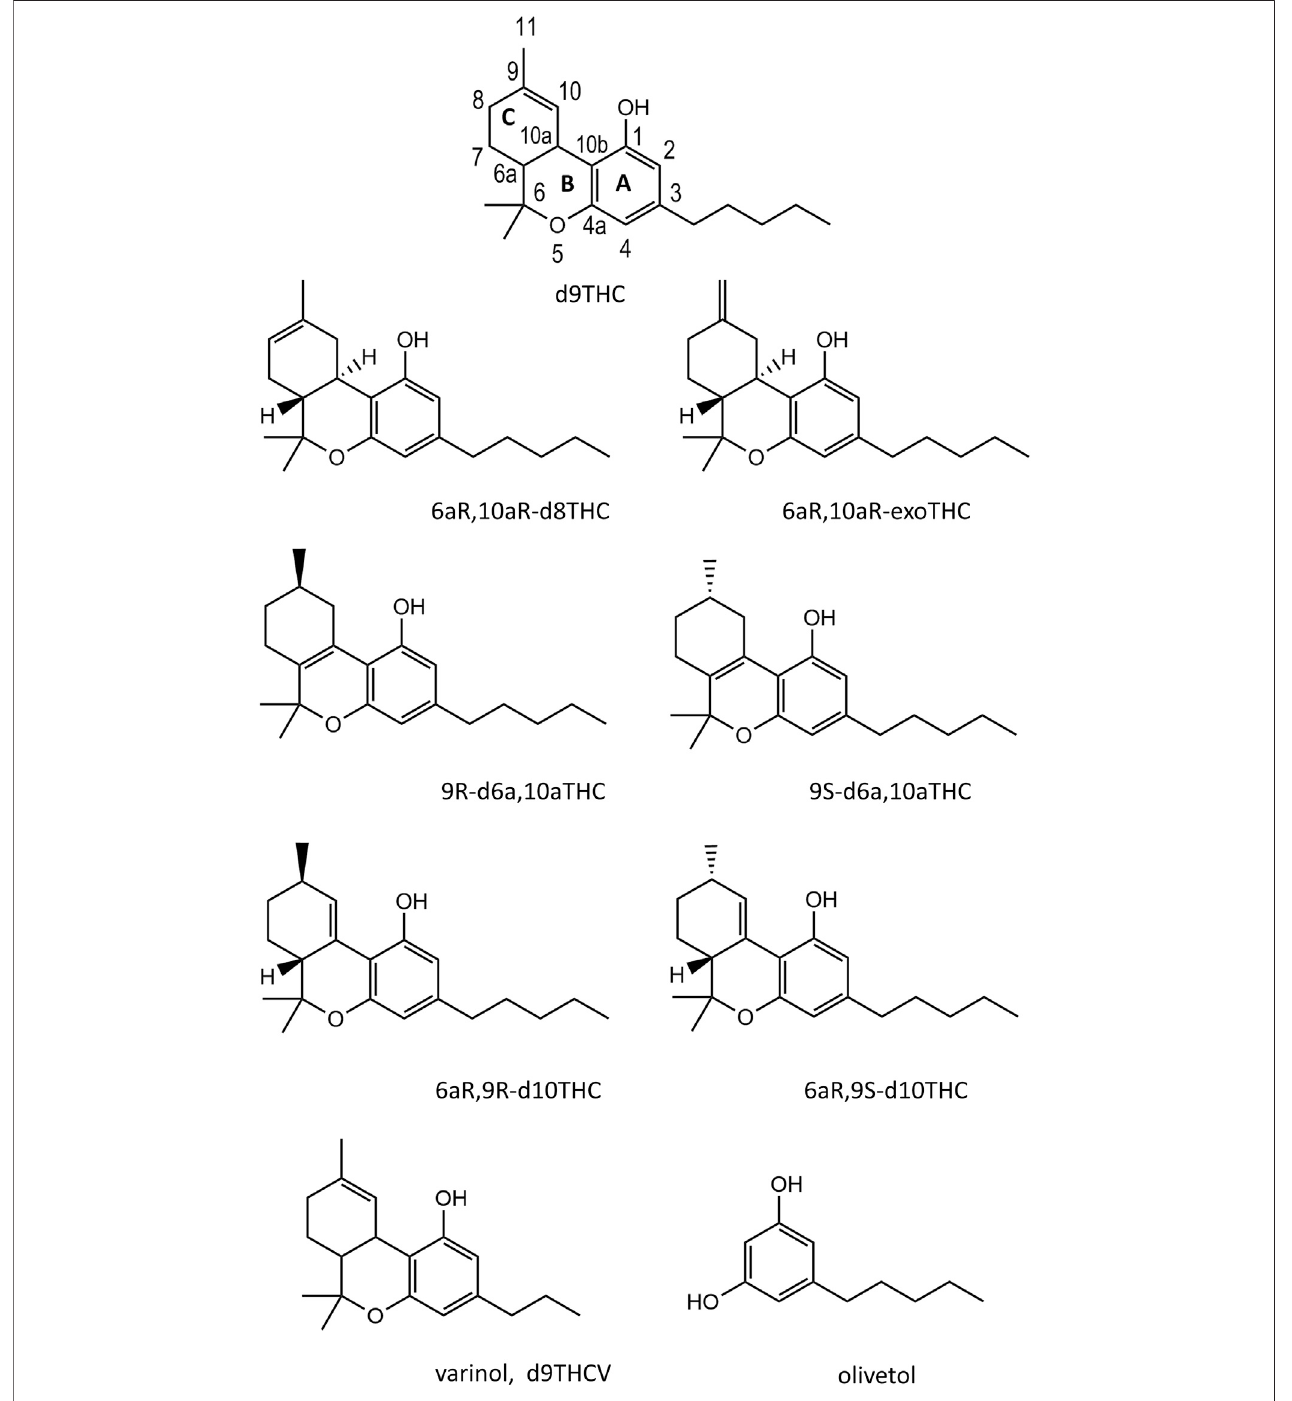
FIGURE 1 | Chemical structures for seven THC isomers, a representative varinol cannabinoid (d9THCV, lowest left structure), and olivetol (lowest right structure).